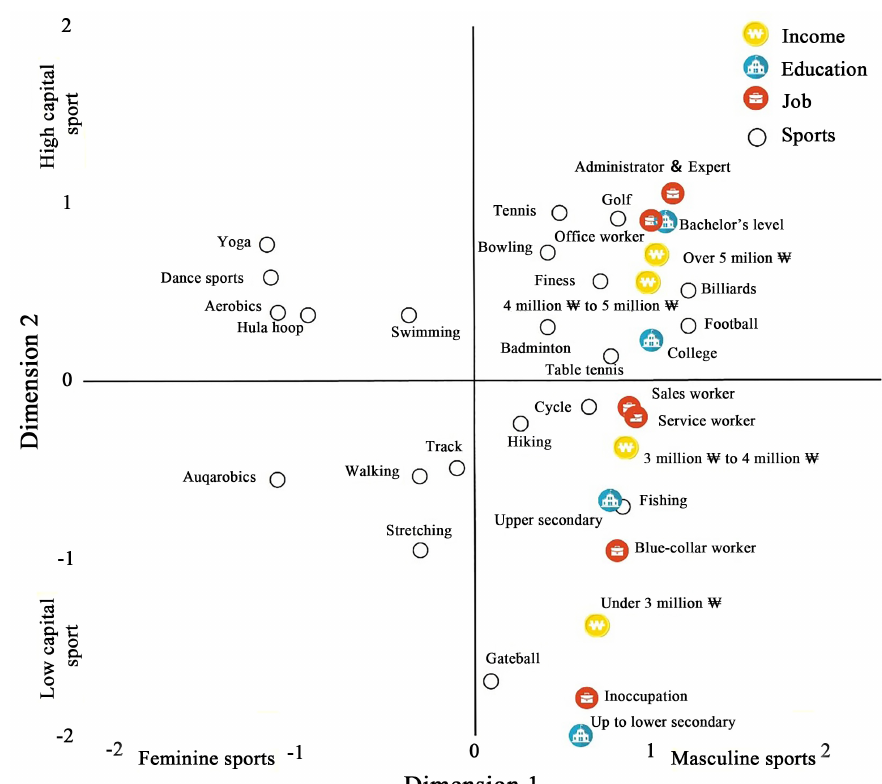
Fig. 2 is a two-dimensional representation of